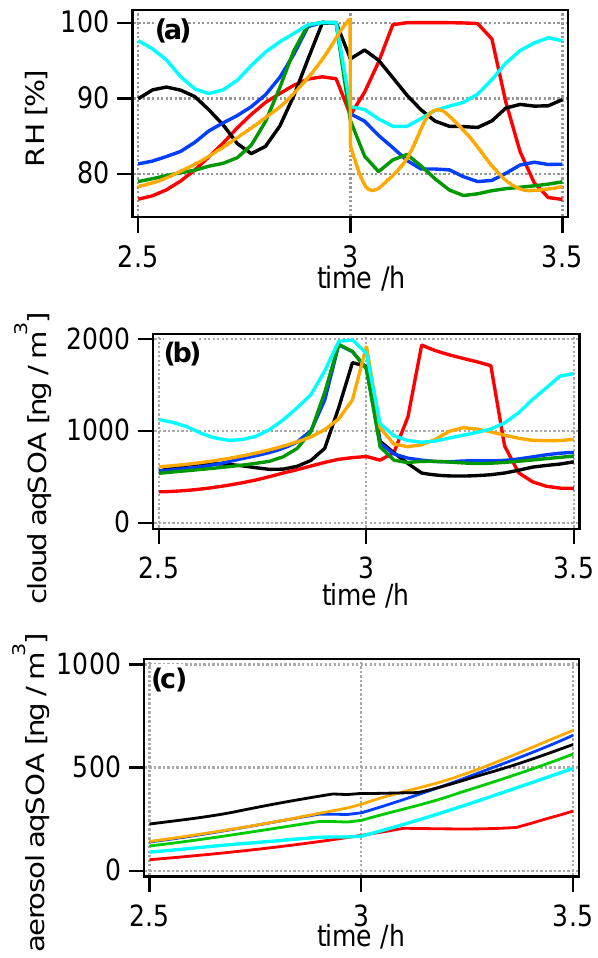
Fig. 3. Results from parcel model studies using six trajectories (dif- ferently colored traces) that differ by temporal evolution of mete- orological parameters (temperature, pressure, RH, in-cloud time, etc.). The chemical mechanism uses reaction parameters for glyoxal and methylglyoxal as listed in Tables 1 and 2 (processes marked with ∗ ). (a) Time profiles of RH for six different trajectories (color- coded); (b) predicted aqSOA formation in aerosol water; (c) pre- dicted aqSOA formation in cloud water. The prediction of similar aqSOA amounts from both sources is a coincidental result and will strongly depend on time scales parcels spend in/outside of clouds, ambient RH, and cloud